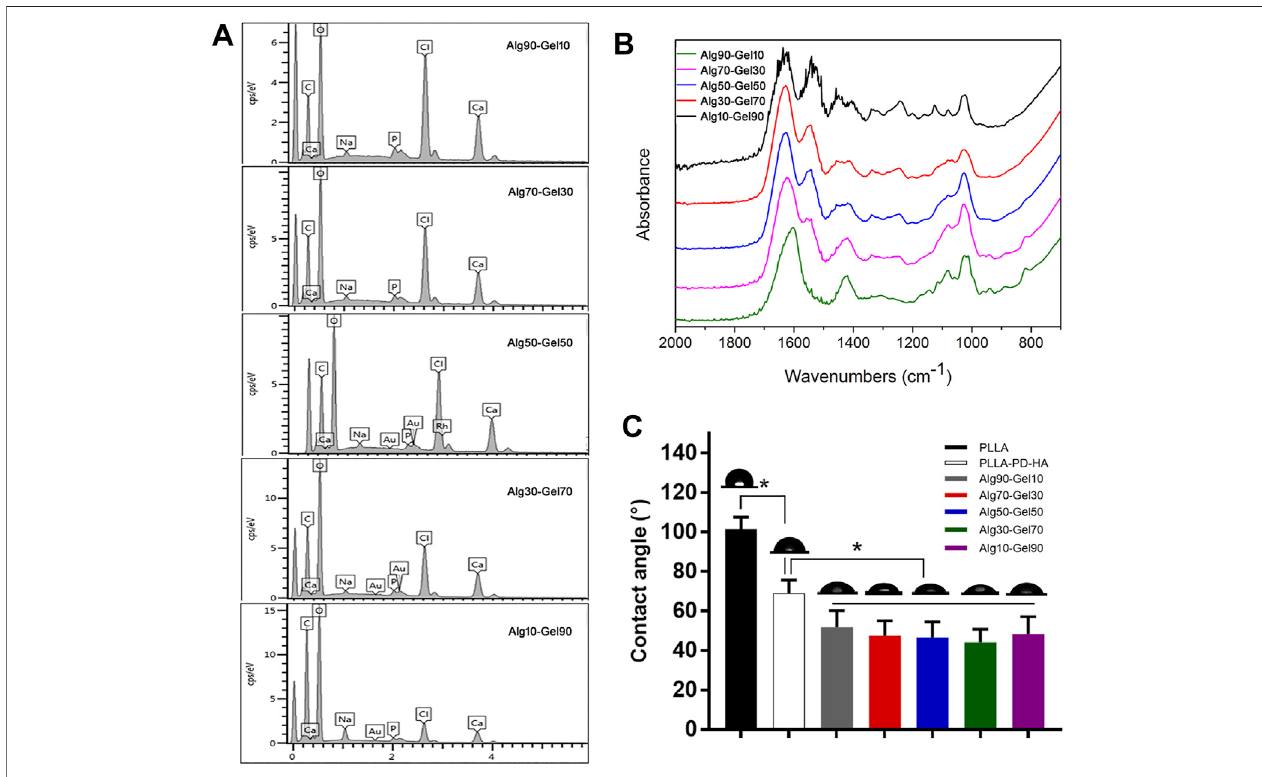
FIGURE 2 | (A) SEM-EDS and (B) FTIR spectra for Alg90-Gel10, Alg70-Gel30, Alg50-Gel50, Alg30-Gel70, and Alg10-Gel90. (C) Contact angle measurement of water on the surface of different samples. FTIR, Fourier transform infrared.